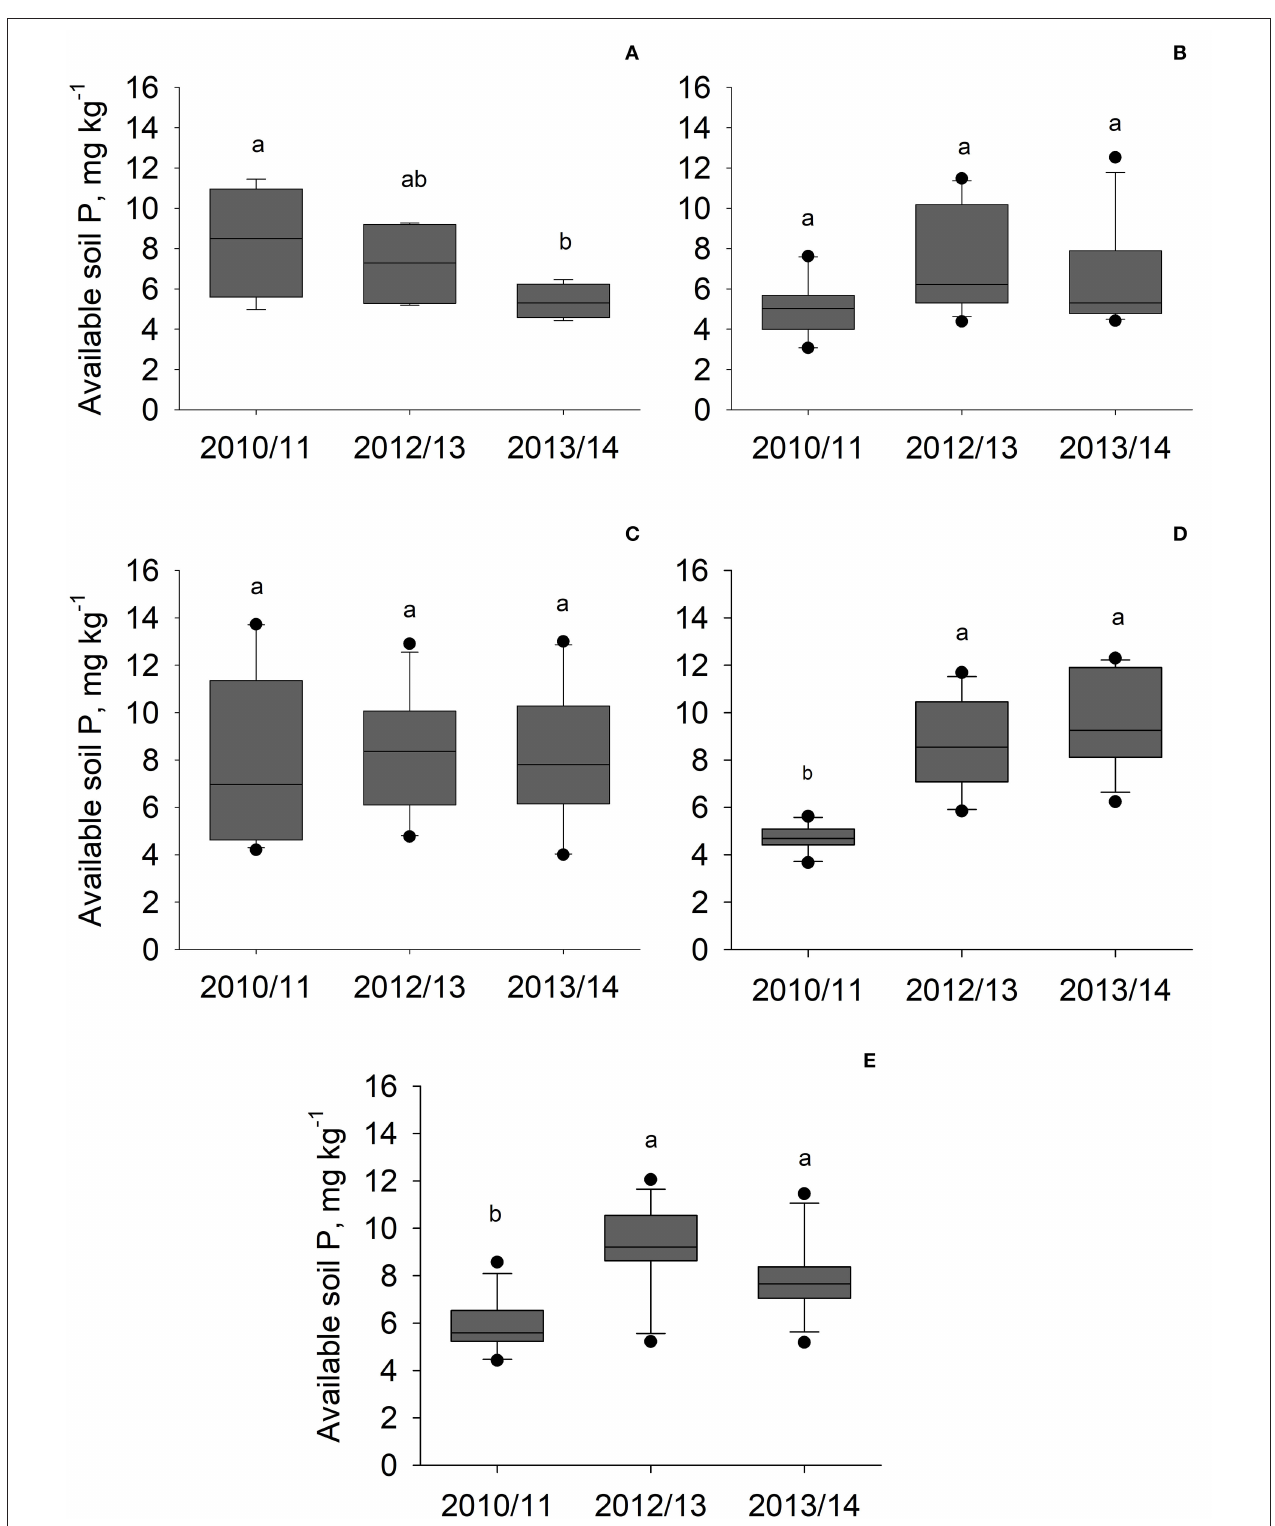
FIGURE 6 | Box and bar plots of available soil P in 3 crop seasons and at different organomineral and MAP fertilizer doses: control (A) , 20 (B) , 40 (C) , 60 (D) , and 80 (E) kg ha − 1 P 2 O 5 . The middle horizontal line is the median value, the extent of the upper box is the first quartile, the extent of the lower box is the third quartile, and 50% of the data lie within the 2 boxes (the interquartile range, IQR). The extent of the bars is the last data point or 1.5 times the distance of the IQR if there are outliers. Outliers are marked with a dot sign in the plot. Means followed by different letters are statistically different p ≥ 0.05 (Tukey’s test).